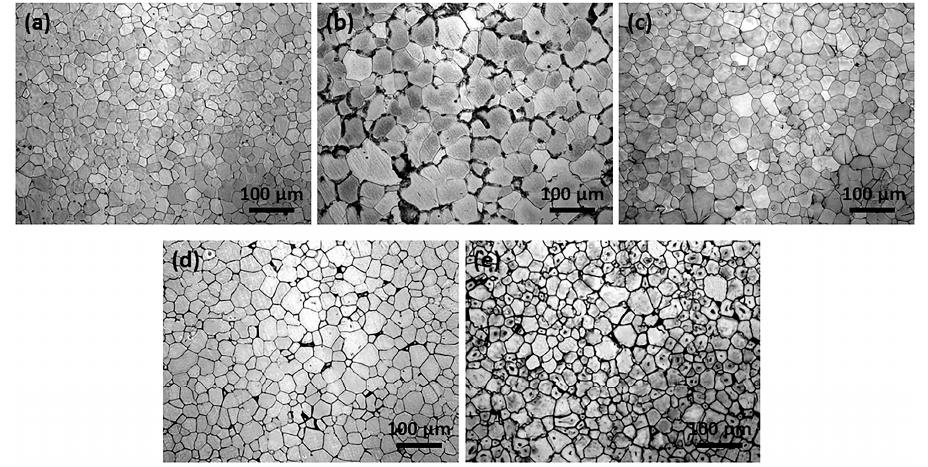
Figure 1. Optical microstructure of the as-cast alloys: ( a ) Alloy1, ( b ) Alloy2, ( c ) Alloy3, ( d ) Alloy4